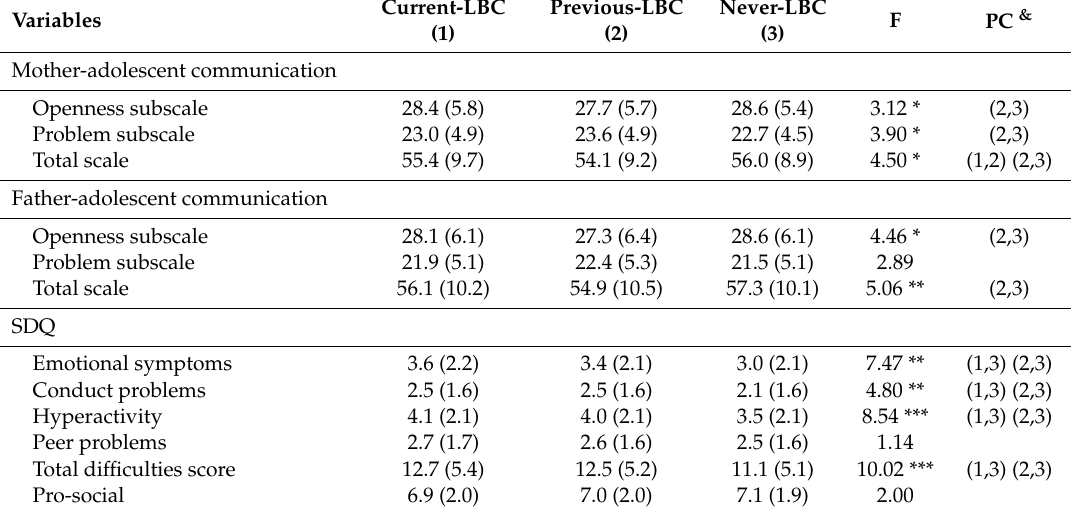
Table 2. Comparisons among current-LBC, previous-LBC, and never-LBC regarding the Parent-Adolescent Communication Scale (PACS) and the Strength and Di ffi culties Questionnaire (SDQ) scores; mean